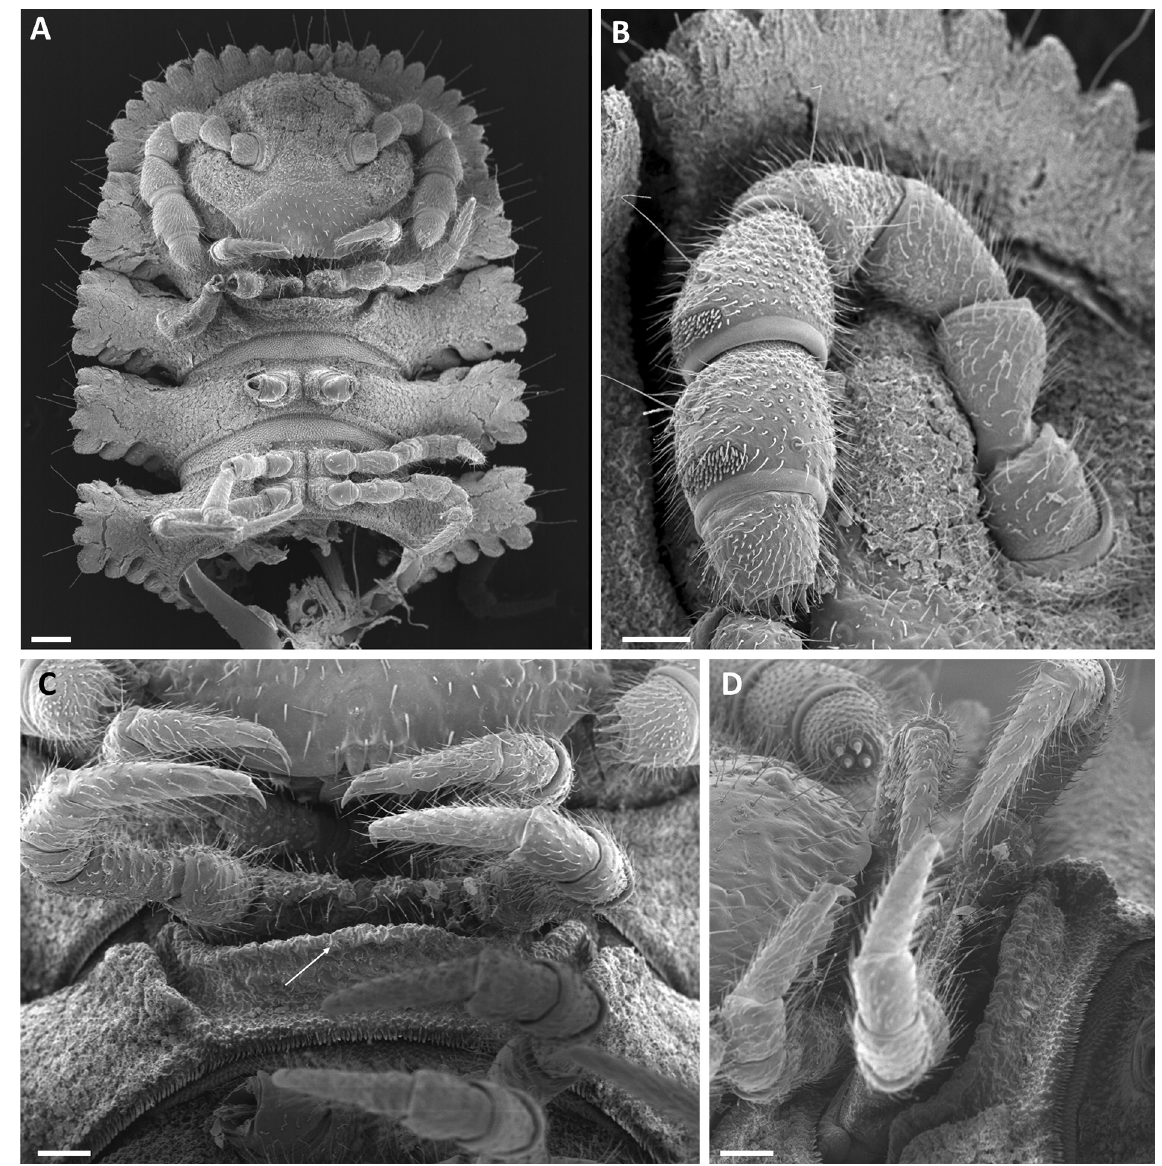
Fig. 15. Elythesmus enghoffi Hoffman, 1978, ♀ (NHMD 621780) from Kidatu. A . Head and rings 1–5, ventral view. B . Right antenna, ventro-latgeral view. C . Leg pairs 1–2, plus left legs 3–4, and epigynal ridge (arrow), ventral view. D . Leg pairs 1–2 and epigynal ridge, ventro-lateral view. Scale bars: A = 0.2 mm; B–D = 0.1